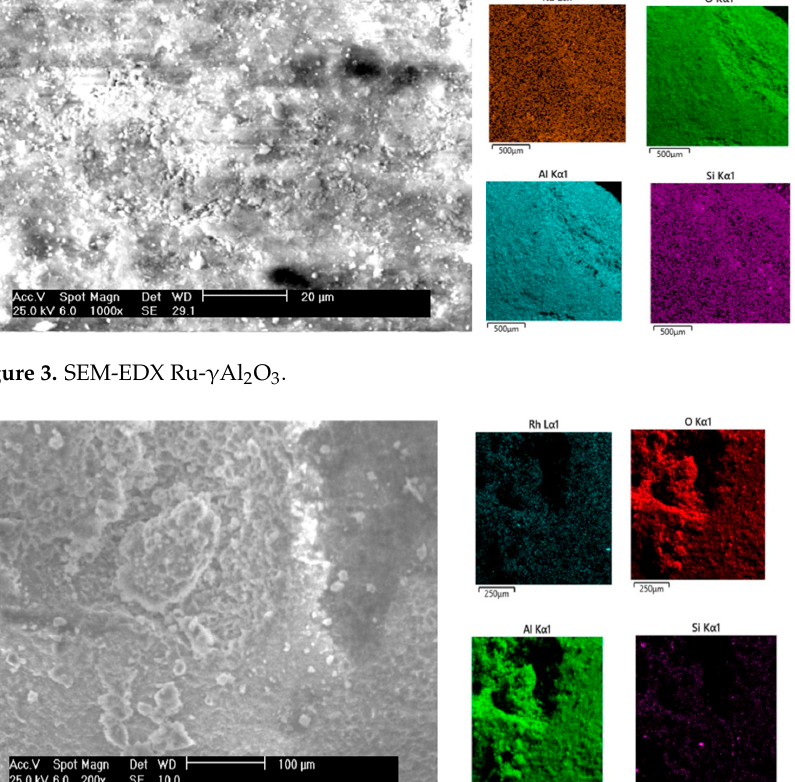
Figure 4. SEM-EDX Rh- γ Al 2 O 3 Figure 4 . SEM-EDX Rh- γ Al 2 O 3 .